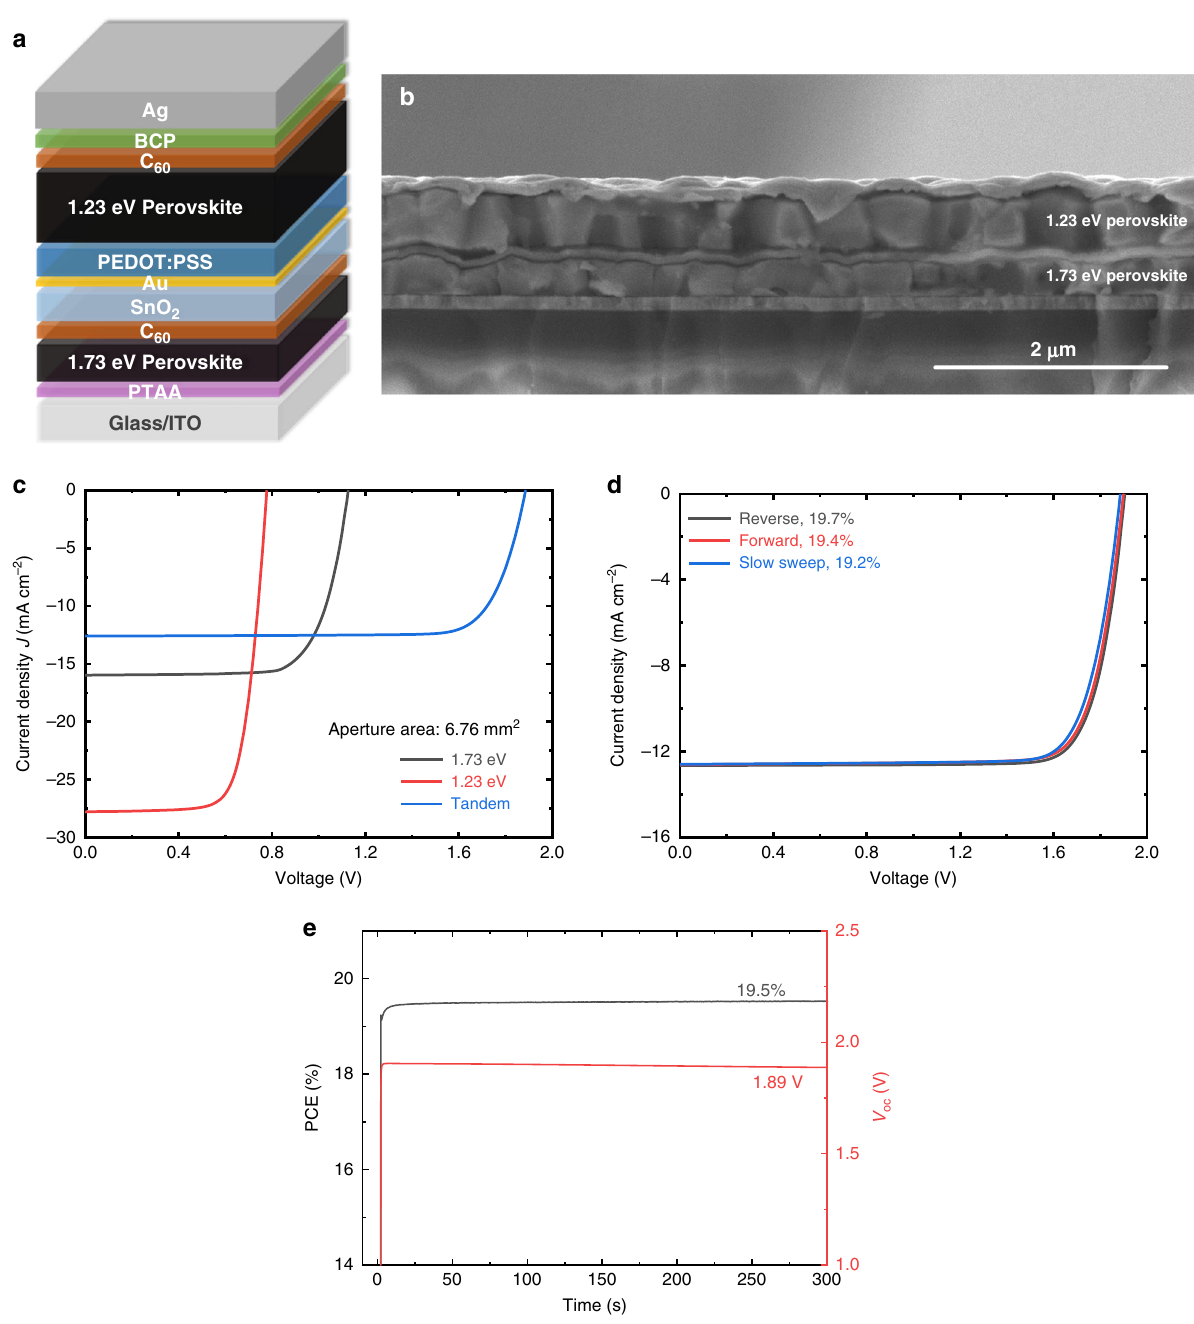
Fig. 3 Device con fi guration and performance of optimized monolithic all-perovskite tandem solar cells. a Device structure. b Corresponding cross- sectional SEM image of the tandem device. Scale bar is 2 μ m. c Stabilized J – V curves of the best-performing tandem cell and the corresponding 1.73 eV and 1.23 eV single-junction PSCs prepared in the same batch (measured with 6.76 mm 2 aperture area). d Reverse, forward, and stabilized J – V scans. e PCE and V oc tracking of the best-performing tandem solar cell. Source data are provided as a Source Data Table 2 Photovoltaic parameters of the single-junction and tandem